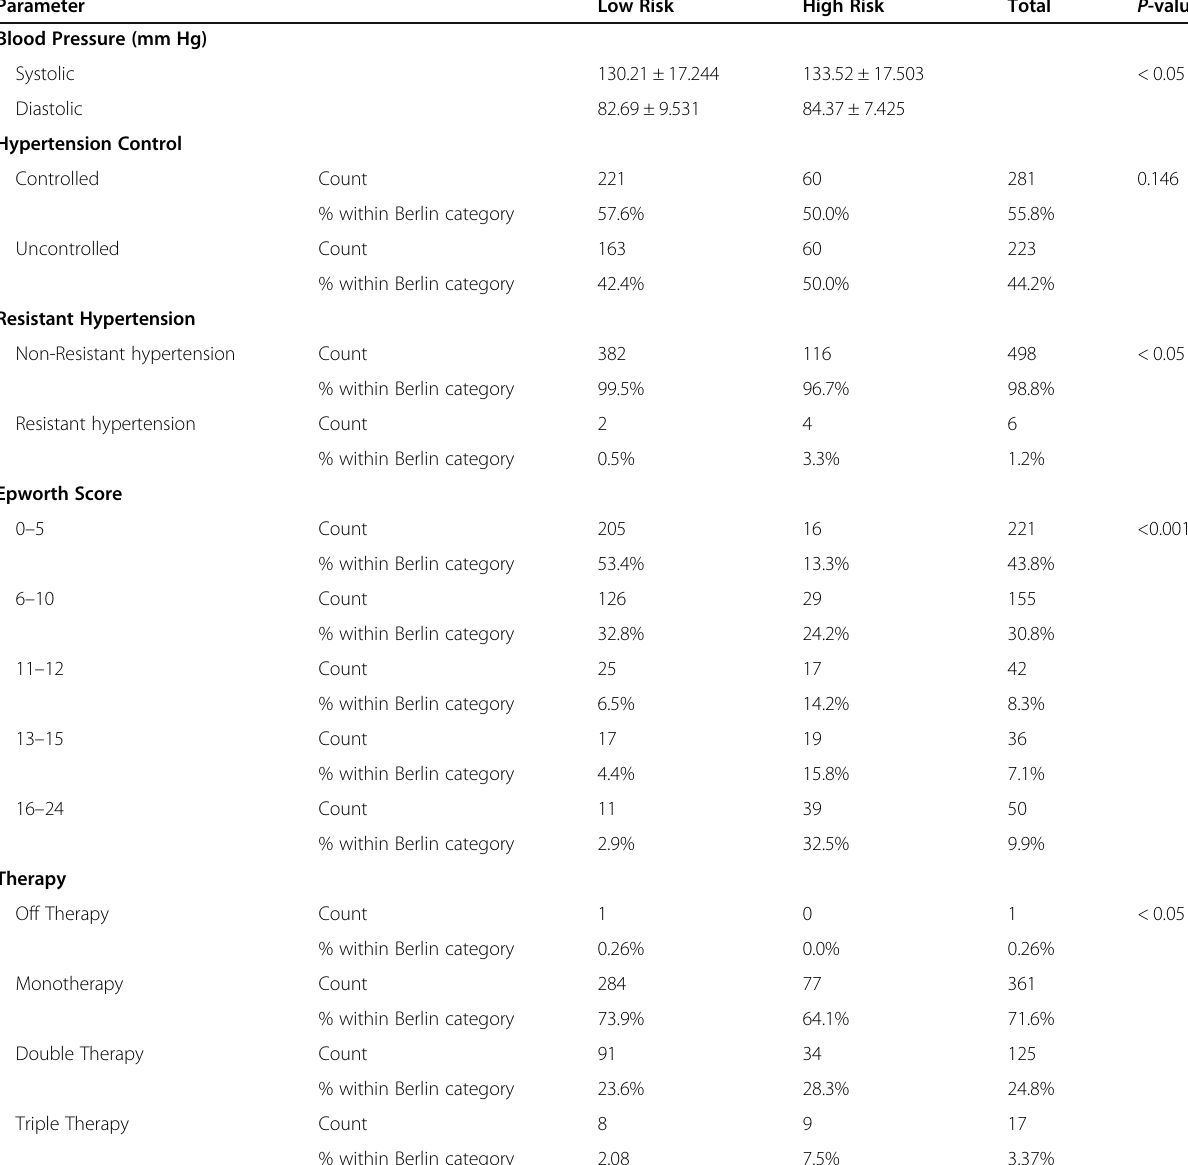
Table 3 Descriptive statistical analysis of various clinical parameters in study patients